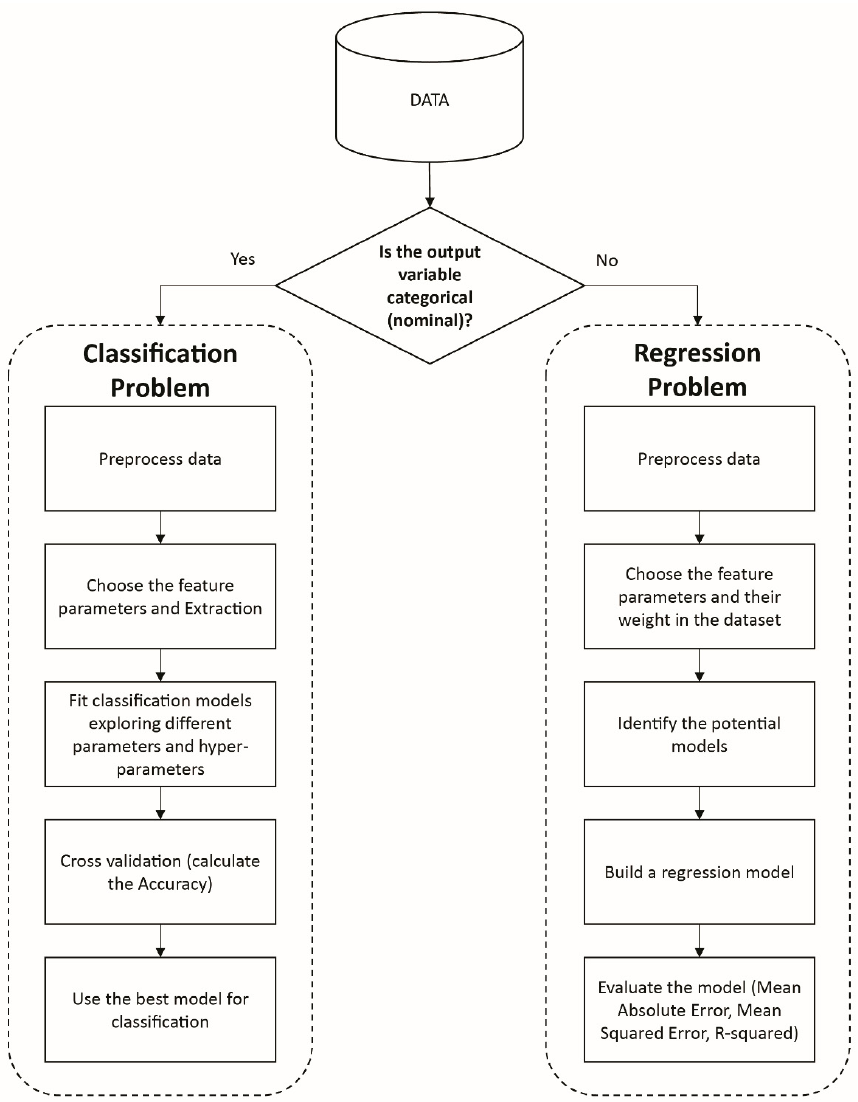
Figure 7. Typical data science main steps in ML.